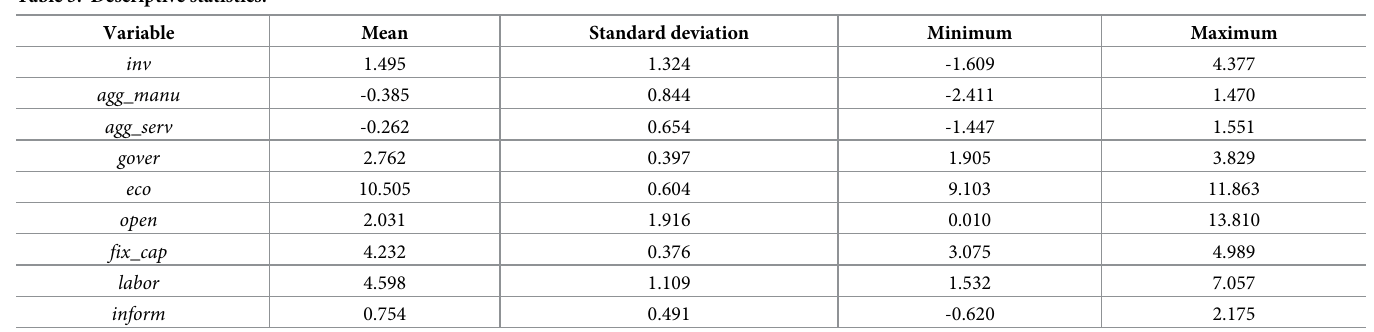
Table 3. Descriptive